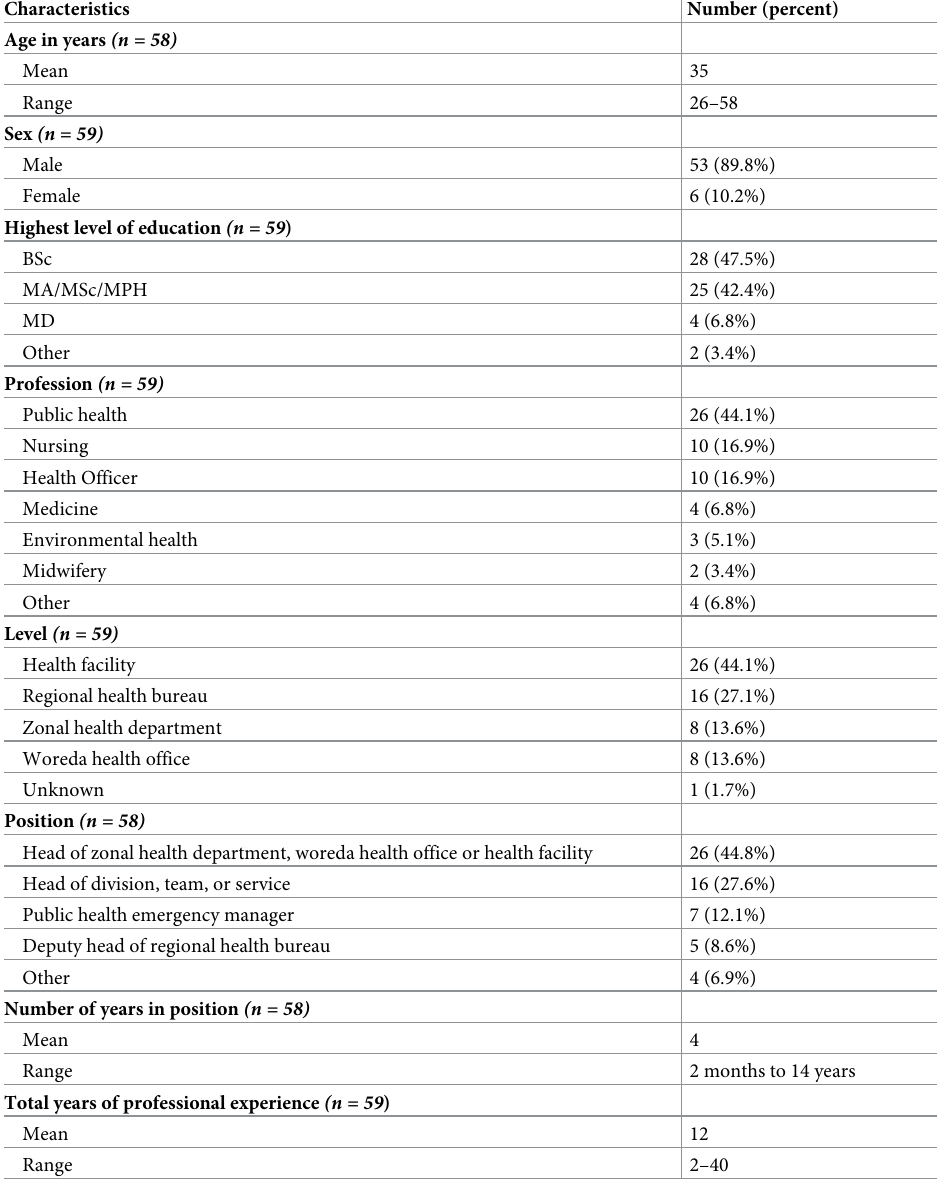
Table 1. Characteristics of study participants in selected primary health care units, Ethiopia, 2020 �